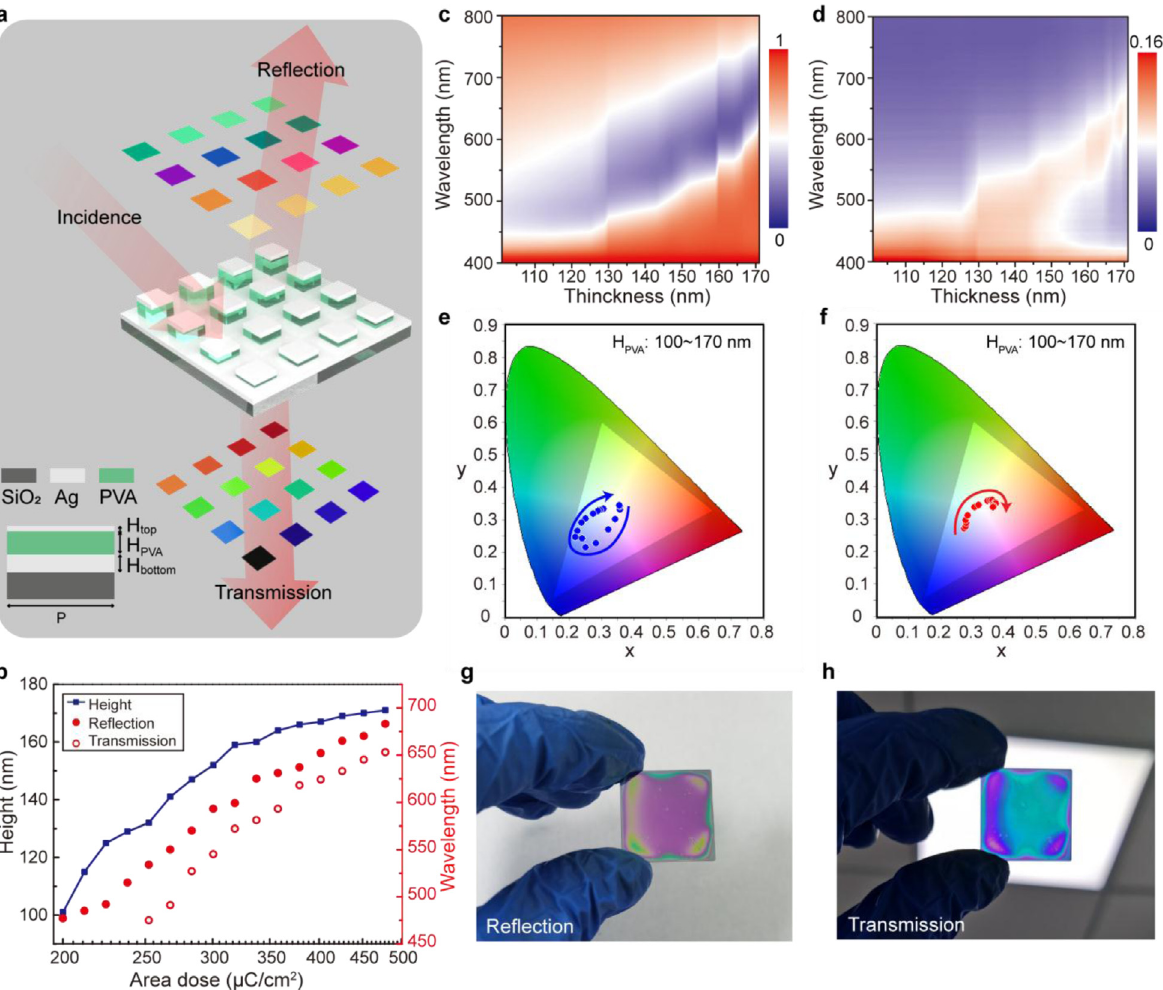
Fig. 1. (a) Schematic of MHM structures displaying dichroism between re fl ection and transmission modes. The MHM structures contain top Ag layer ( H top =10 nm), PVA layer ( H PVA : 100 – 170 nm) and bottom Ag layer ( H bottom = 30nm). (b) Height of PVA (the blue line), re fl ection and transmission resonances (the red dots and red circles respectively) of the corresponding MHM structures fabricated with varied EBL exposure dose. 2D contours of (c) re fl ection and (d) transmission spectra of MHM structures with the varied H PVA of 100 – 170 nm. Corresponded 1931CIE diagrams with the varied H PVA of 100 – 170nm for (e) re fl ection and (f) transmission modes, respectively. Photographs of large-area MHM fi lm showing different color for (g) re fl ection and (h) transmission modes visible to naked